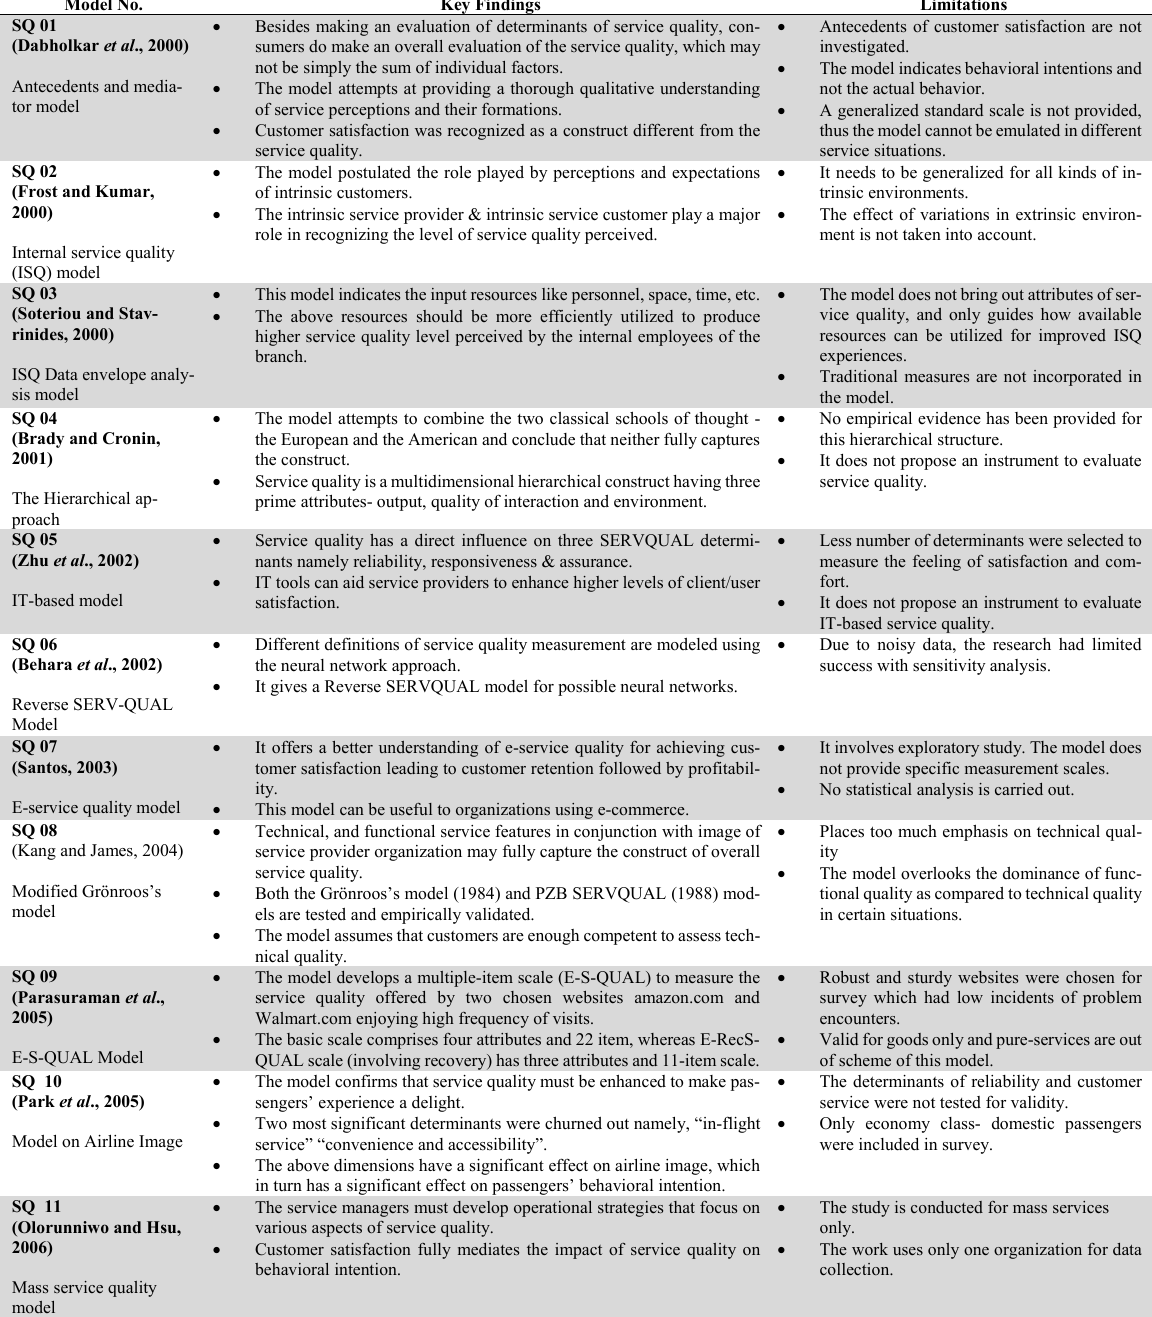
Summary Evaluation of Service Quality Models in the new